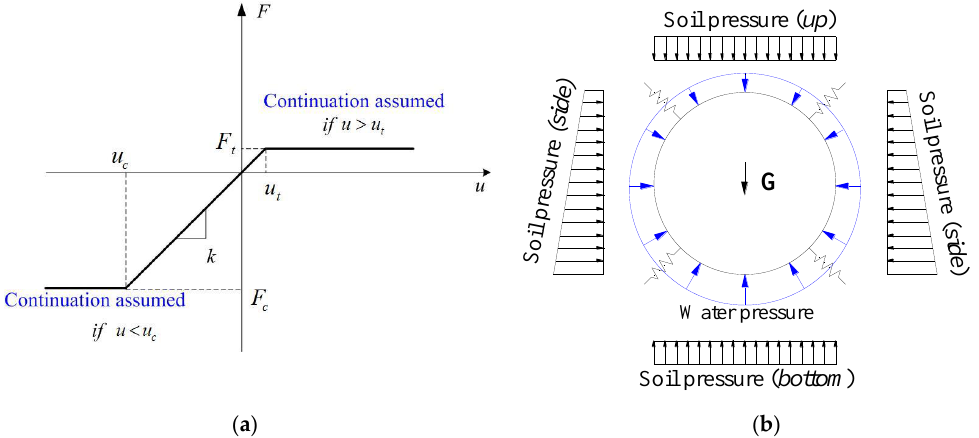
Figure 3. Methodology for the numerical modeling: ( a ) the force-relative displacement curve of a non-linear spring; ( b ) boundary conditions of the improved model.